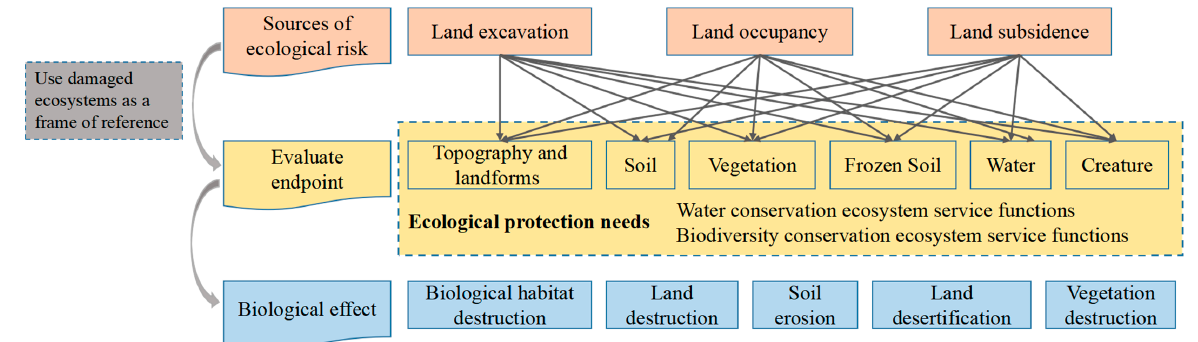
Figure 2. Schematic diagram of research ideas.